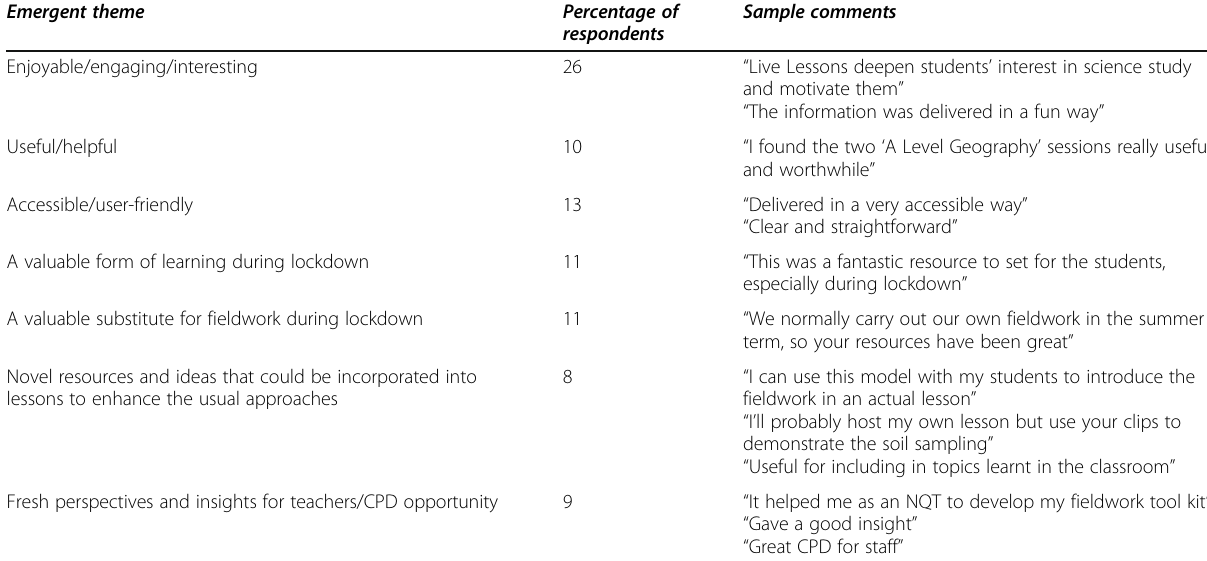
Table 1 Emergent themes in the content analysis for response data to the question: “ Please let us know the reason for why you would recommend the live lessons to other teachers or education providers ” ( n = 187). Only themes with > 5% respondents are